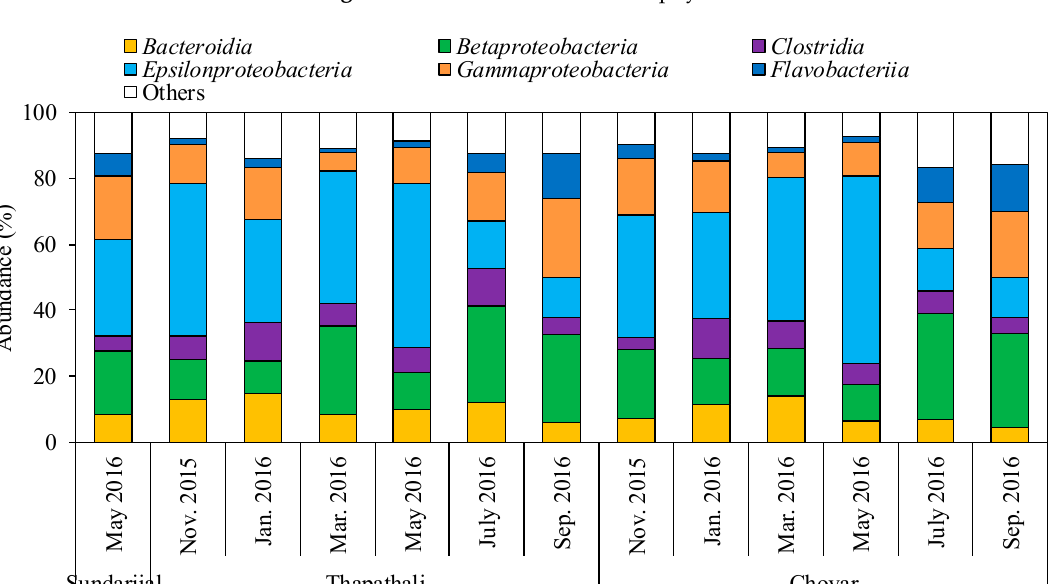
Figure 2. Distribution of bacterial phyla.